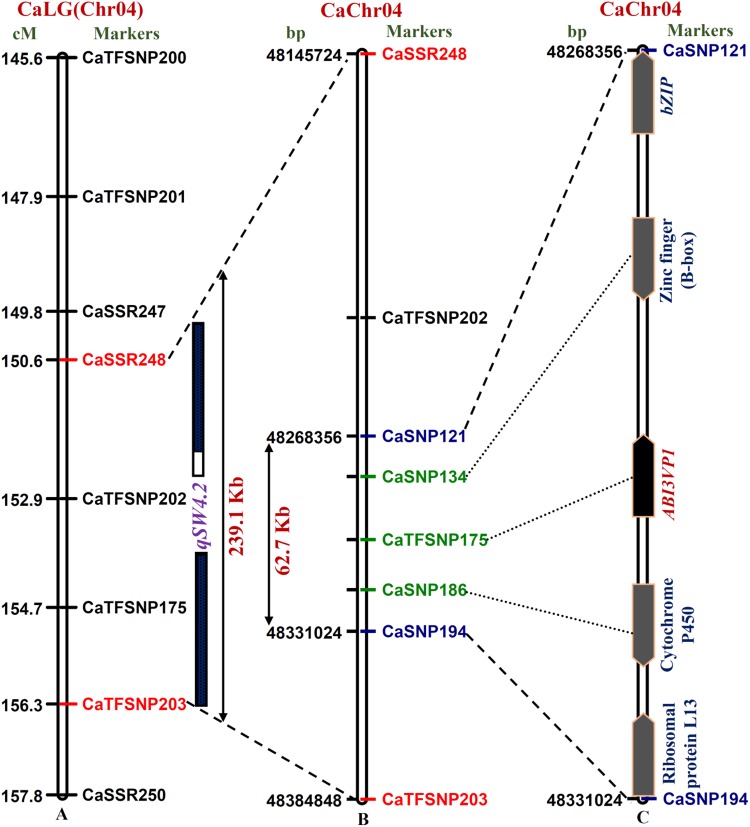
Integration of genetic (A) and physical (B) map of target genomic region harbouring one robust SW-regulating major QTL (qSW4.2) identified and mapped QTL on 239.1 kb sequence interval (indicated by red-coloured flanking marker pairs) of chickpea chromosome 4. This QTL was further delimited to an ∼62.7 kb sequenced region on chromosome 4 by integrating traditional QTL mapping with QTL region-specific association analysis (B). Five protein-coding candidate genes annotated within 62.7 kb sequenced interval between markers CaSNP121 and CaSNP194 (marked with blue colour), of which ABI3VP1 TF gene showed strong association with SW in chickpea (C). The genetic (cM)/physical (bp) distance and identity of the markers mapped on the chromosomes are indicated on the left and right sides of the chromosomes, respectively. The green-coloured markers are derived from the chickpea genes annotated at 62.7 kb QTL (qSW4.2) interval. The markers genetically and physically mapped on chickpea chromosome 4 are coloured with black. This figure appears in colour in the online version of DNA Research.